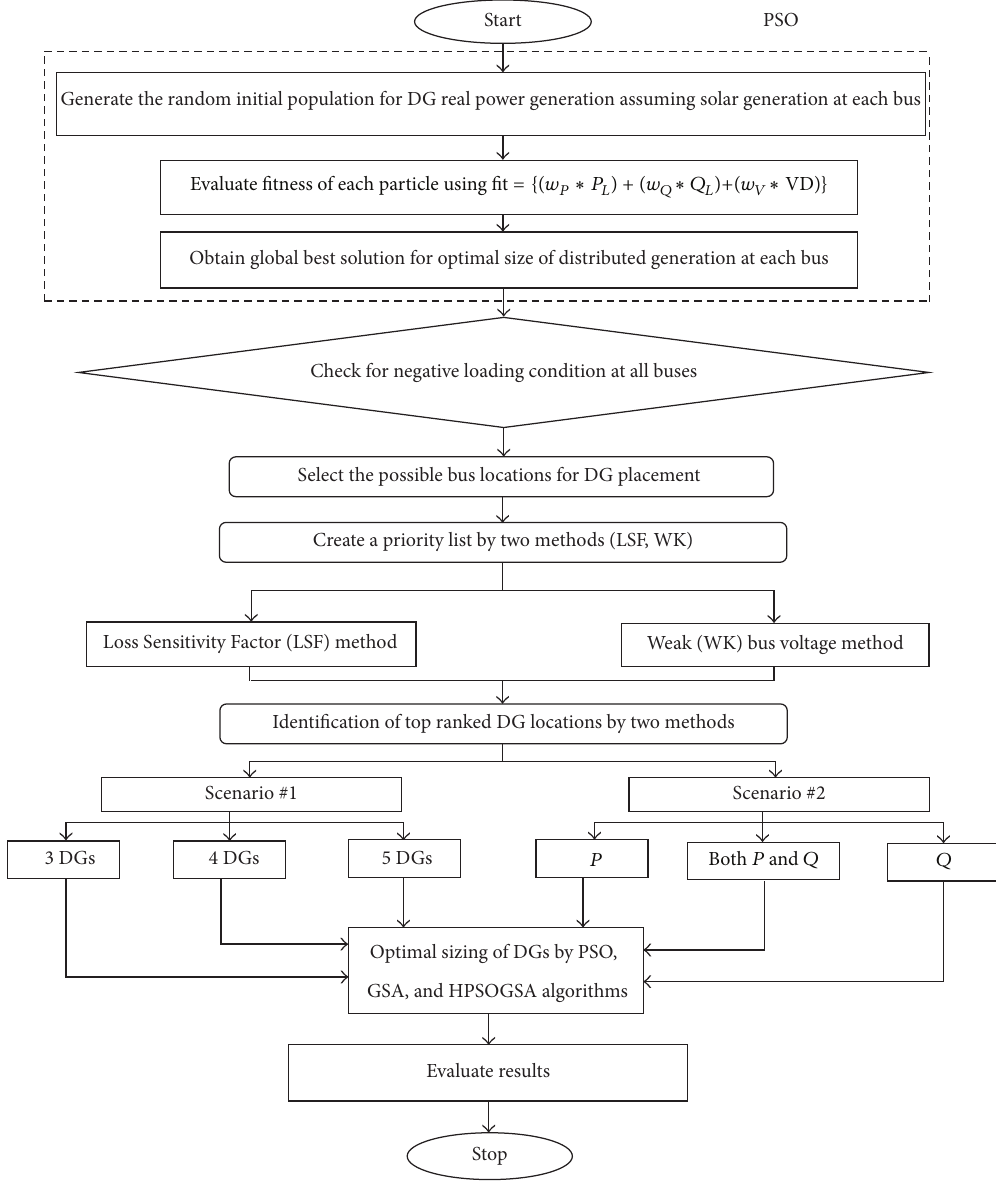
Figure 1: Flowchart showing the proposed